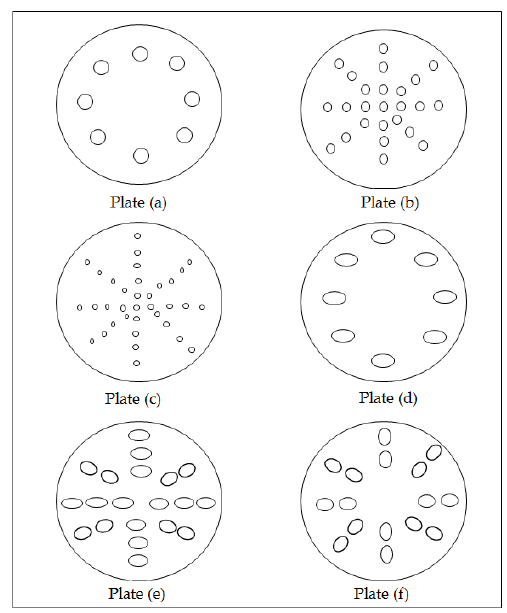
Figure 2. Schematic representation of HC reactor.